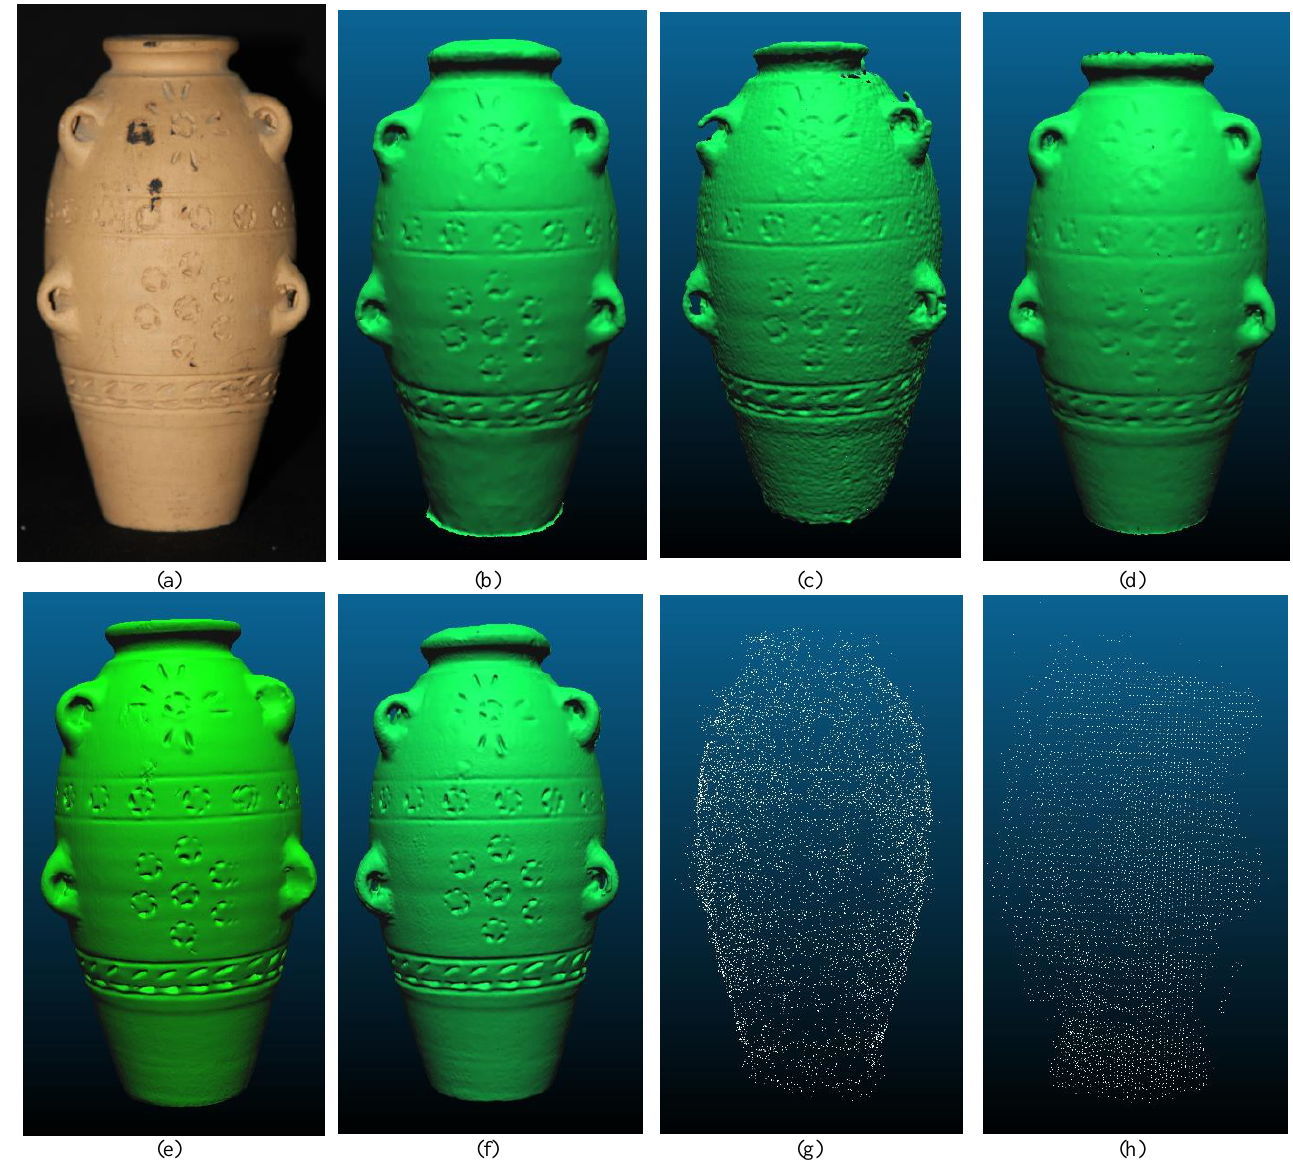
Figure 7: (a) Clay Object, (b) 3D model created from 123dCatch, (c) 3D model created from Arc3D, (d) 3D model created from Photoscan, (e) 3D model created from Next Engine, (f) 3D model created from SL2, (g) Point cloud generated by Photosynth, (h)